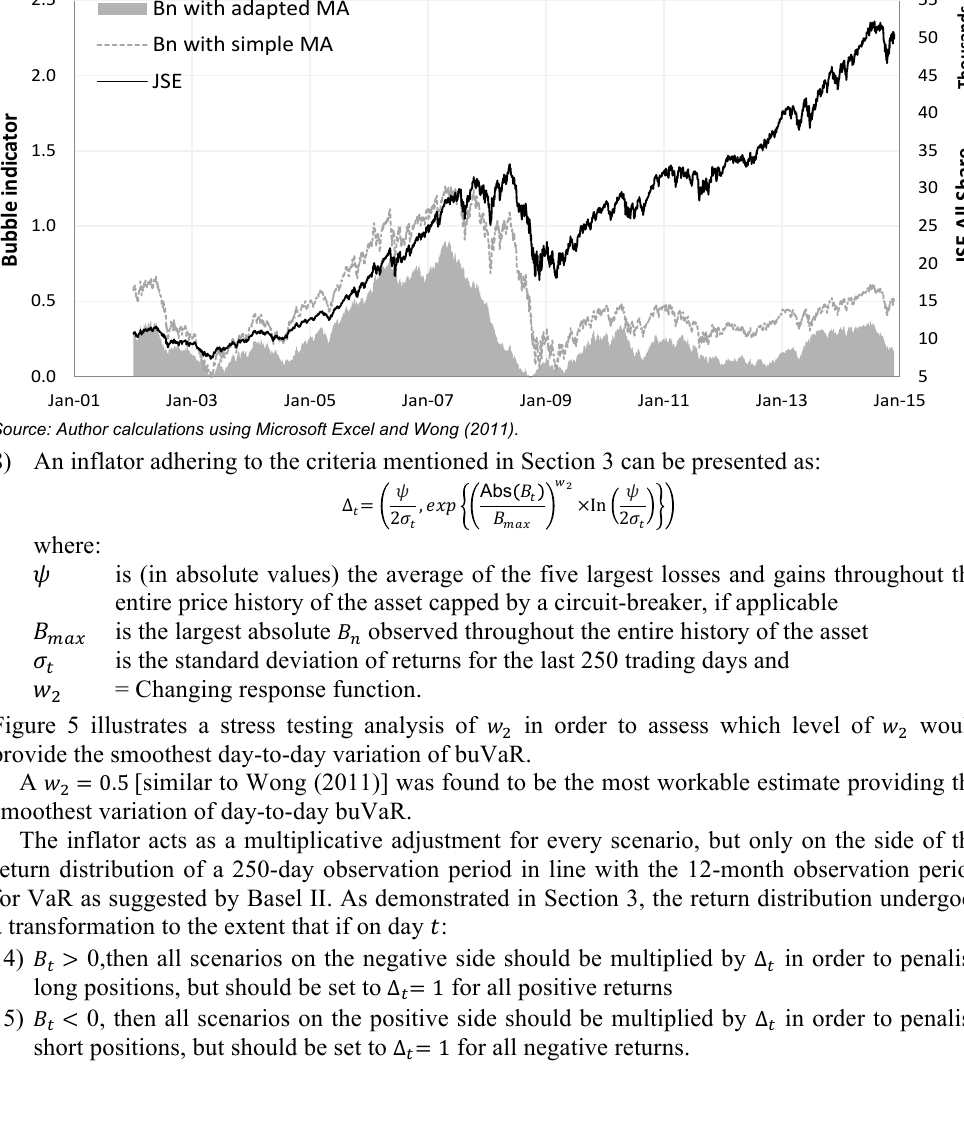
Bubble indicator estimated using simple MA and adaptive